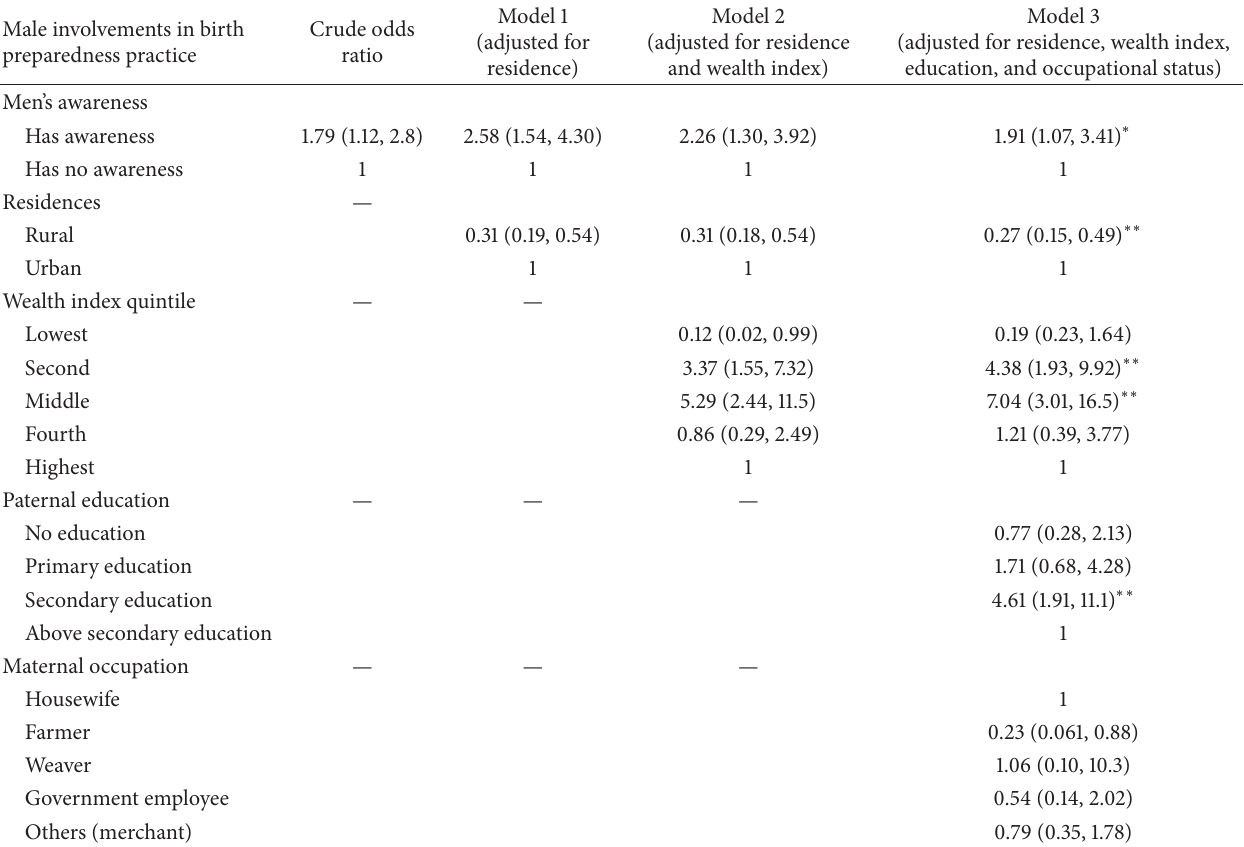
Table 3: Association (odds ratio, 95% CI) between men’s awareness of danger signs of obstetric complications and birth preparedness: hierarchical logistic regression analysis.